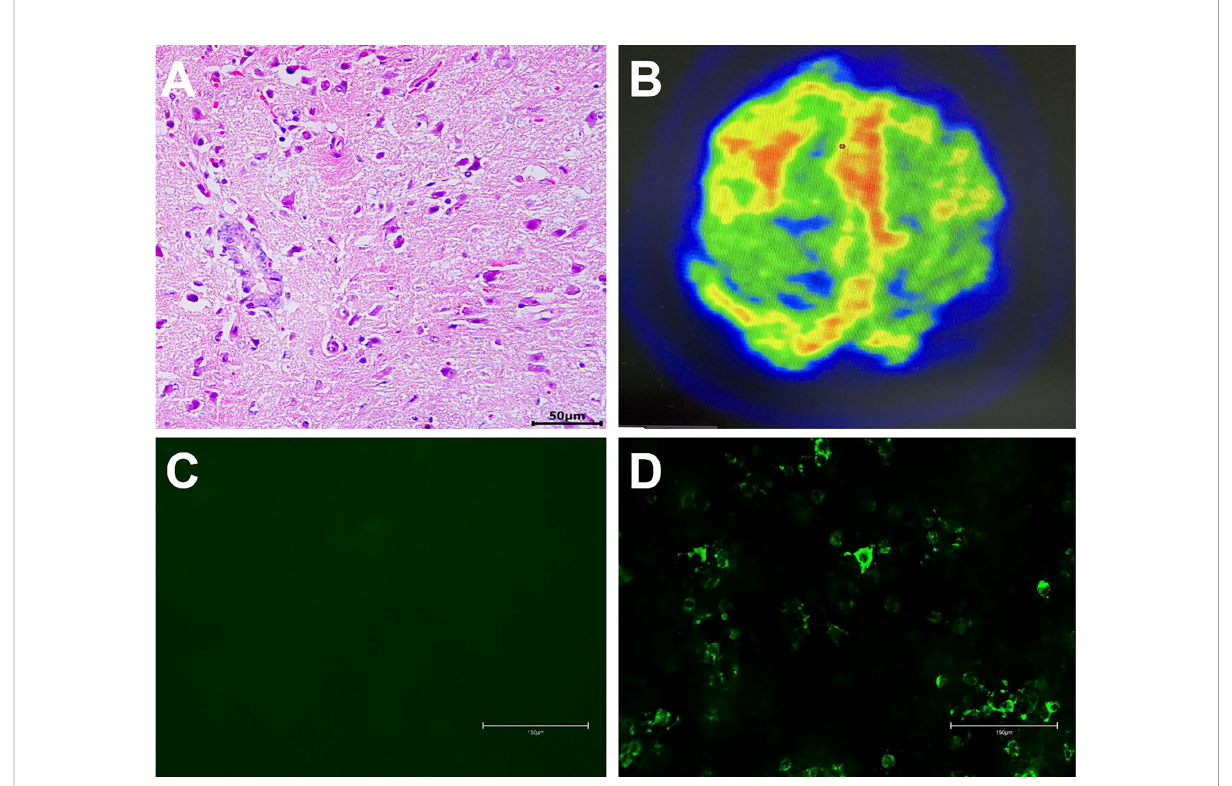
FIGURE 2 A non-speci fi c in fl ammation and no rheumatoid nodules in the meninges (H&E, scale bar=50 µm, (A) . 18 F-FDG PET/CT scan showed hypermetabolism of bilateral frontal-parietal meninges and adjacent cortex, especially on the right side (B) . NMDAR Abs were absent in serum (scale bar=150 µm, (C) ), and NMDAR Abs (1:1) were detected in the CSF (scale bar=150 µm, (D)